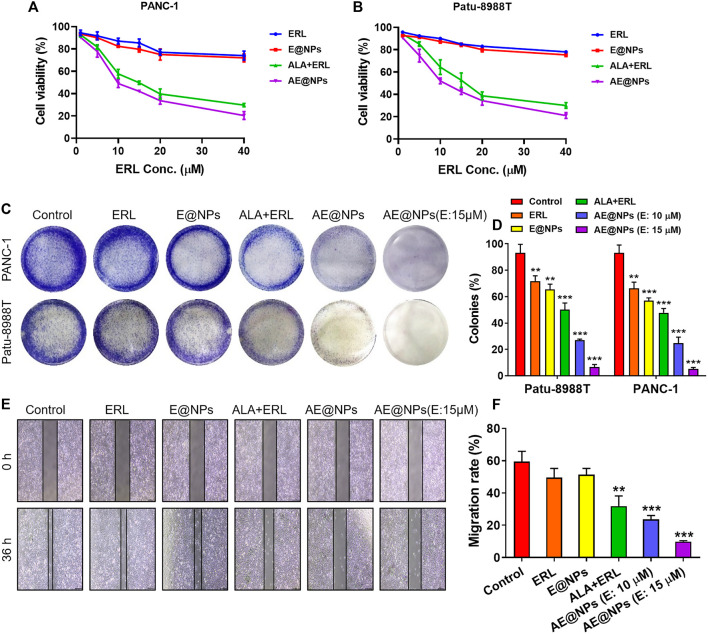
The enhanced anticancer efficacy of AE@NPs in pancreatic cancer cells. MTT assay was conducted to investigate the cell-killing effect of AE@NPs in (A) PANC-1 and (B) Patu-8988T cells (C) Colony forming assay in PANC-1 and Patu-8988T cells. The colonies were fixed with 4% paraformaldehyde and stained with crystal violet (D) The colony forming assay was quantified by the absorption of dissolved stain at 630 nm (E) The anti-metastasis capability of AE@NPs was studied by wound healing assay and (F) the corresponding quantitative analysis. Magnification: ×100. The data were shown as mean ± SD. Experiments were performed was performed in triplicates. *p < 0.05 **p < 0.01, ***p < 0.001, compared to the control group.